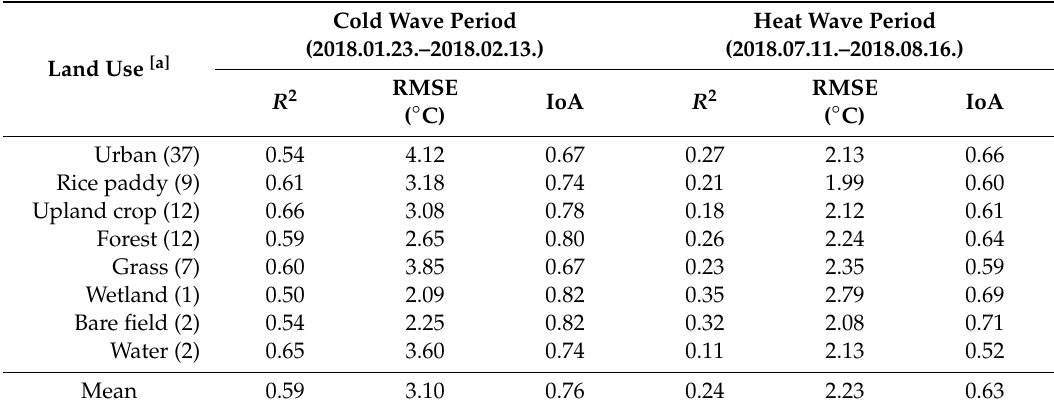
Table 3. The statistical indicator ( R 2 , RMSE, and IoA) results of 8 land use classes during the cold wave period (2018.01.23.–2018.02.13.) and heat wave period